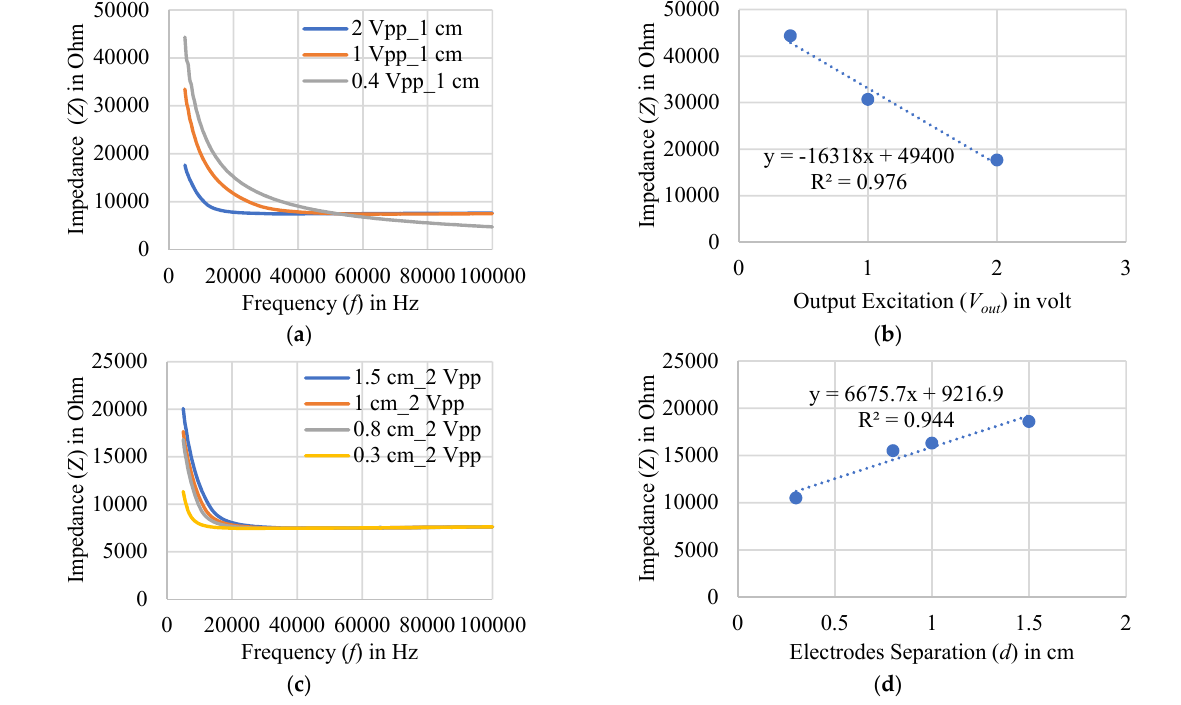
Figure 6. EIS measurements of a carrot slice using two-electrode method ( a ) by varying output excitation, and ( b ) the corresponding correlation. EIS measurements ( c ) by varying separation of the electrodes, and ( d ) the corresponding correlation. A good correlation with more than 95% coefficient was found for the measurements using 2 Vpp excitation and 1 cm spacing of the electrodes. In this work, two approaches were taken for the measurements in homogeneous and inhomogeneous media of the EIT domain. The EIT domain was filled with water to create the homogeneous media. A continuous signal of 2 Vpp excitation was applied to the EIT sensor system, and the measurements were carried out. At first, a two-pole method was applied, and EIS measurements were carried out using an EVAL-AD5933EBZ impedance analyzer. The impedances for different layers of electrodes in the domain were obtained for different frequencies of 1–100 kHz. A total of 64 measurements (1-1, 1-2, 1-3, 1-4, 1-5, 1-6, 1-7, and 1-8 with respect to electrode 1; 2-1, 2-2, 2-3, 2-4, 2-5, 2-6, 2-7, and 2-8 with respect to electrode 2, and so on) were taken from the eight-electrode system in one layer for 2D. In addition, the measurements were taken in other layers of the sensor electrode array for 3D. A constant current source of 1 mA sinusoidal current with varying frequency was found suitable for EIT [10,11,23]. The current is injected through the electrodes of the array and the obtained boundary voltages for a single layer of the EIT sensor are depicted in Figure 7.